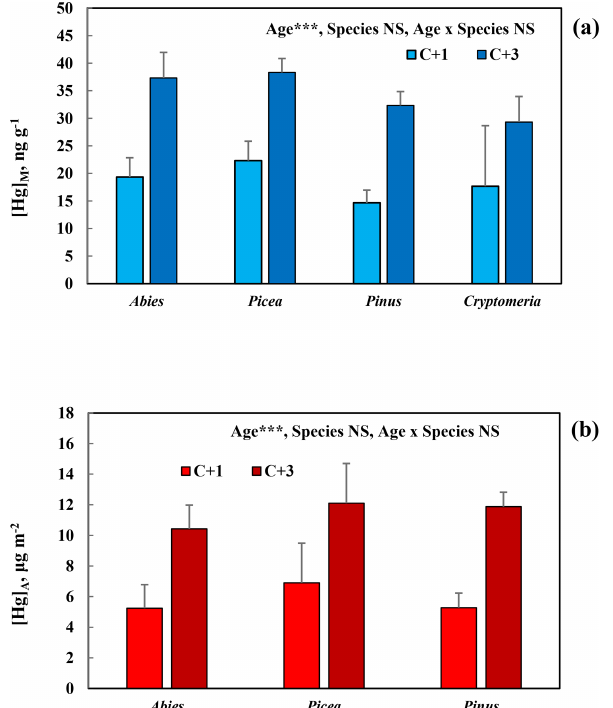
Figure 3. Mass-based [Hg] M (a) and area-based [Hg] A (b) in 1- year-old (C + 1) and 3-year-old (C + 3) needles of Pinus nigra at three sites in the Gothenburg area including the arboretum. Error bars show standard deviation for the three trees sampled per species. ∗∗∗ p < 0 . 001; NS, non-significant. Site locations and characteris- tics are available in the supporting